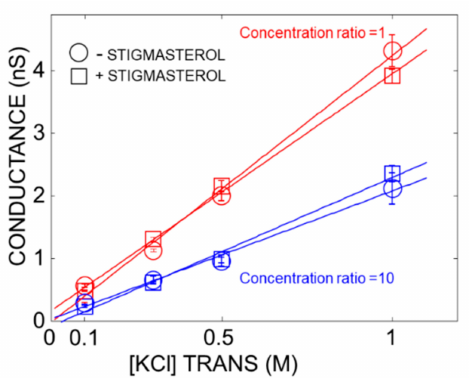
Figure 3. Effect of ion concentration on the PcVDAC conductance. The experiments were performed either in the presence of identical ion concentration on each side of the membrane (red symbol) or in the presence of a concentration ratio [KCl] Trans /[KCl] Cis = 10 (blue symbol). The membrane was either free of stigmasterol (circle symbol, number of replicates: 3–19) or doped with 10% stigmasterol (square symbol, number of replicates: 5–9). The goodness of the linear fits are r 2 > 99 (red circle), r 2 > 99 (red square), r 2 > 99 (blue circle) and r 2 > 99 (blue square). The solutions were buffered at pH 7.5 with 10 mM